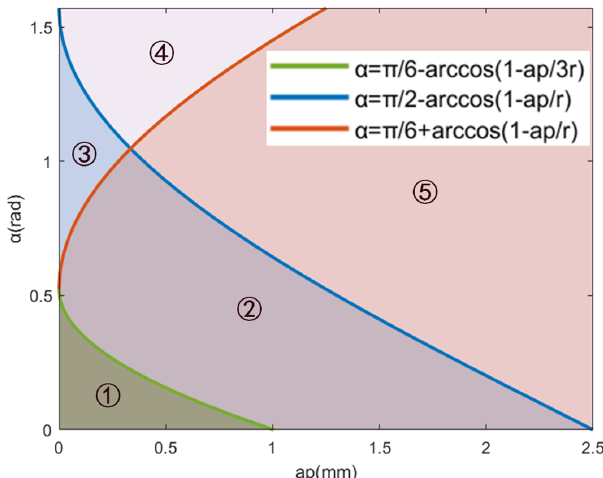
Figure 6. Relationship between cutting mode, inclination angle α , cutting depth a p , and tool parameter r .